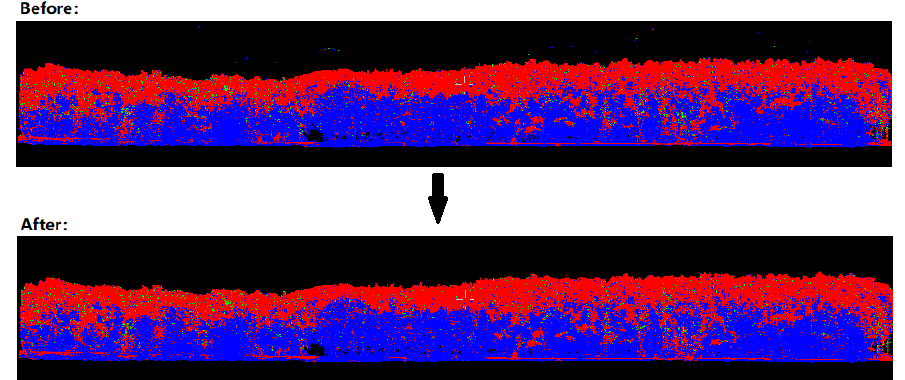
Figure 4. The rendering of denoising step. There are plenty of noise points above the forest before denoising while there are not much after denoising.